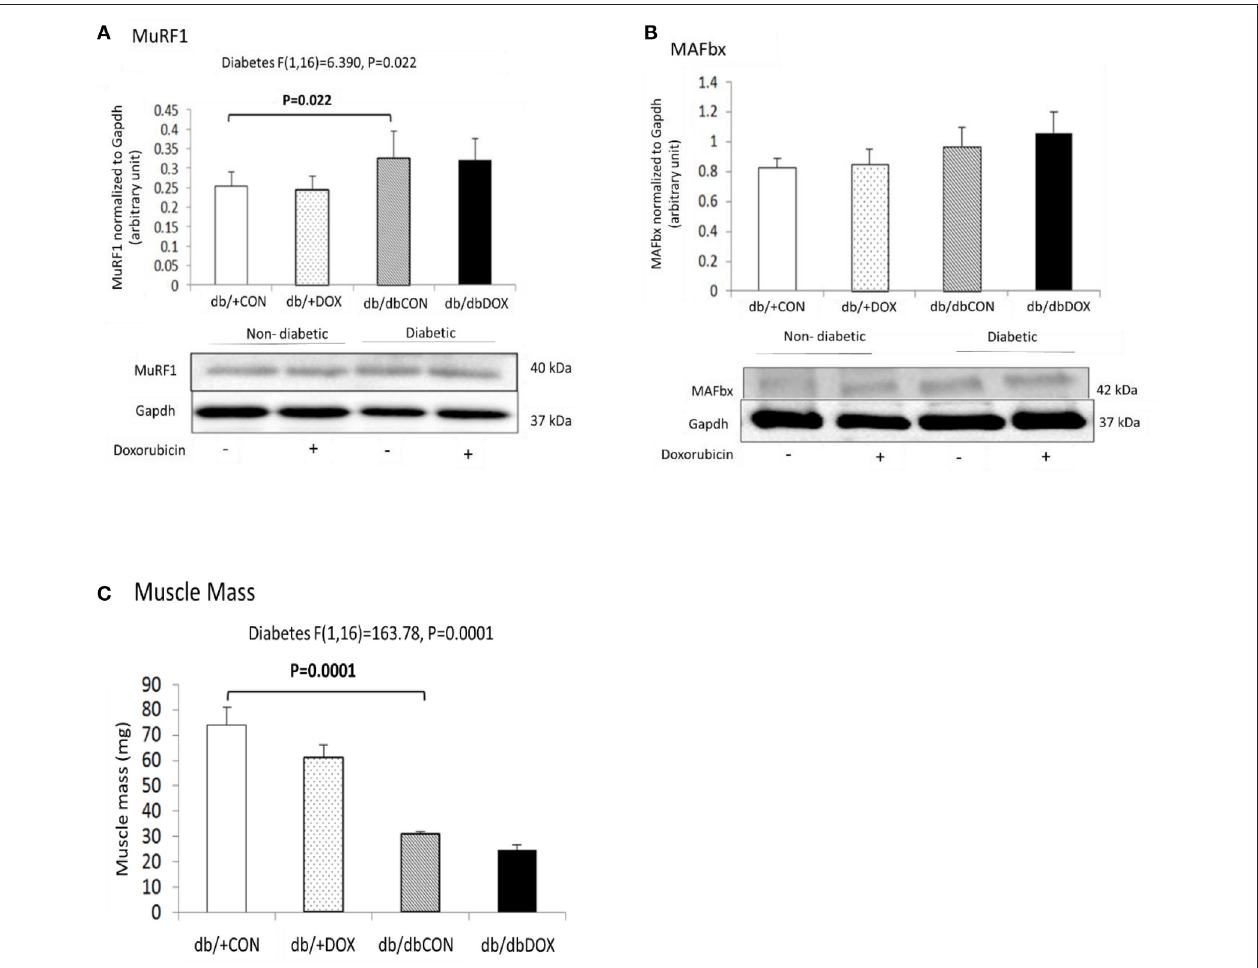
FIGURE 2 | Non-diabetic and diabetic skeletal muscle atrophy after DOX exposure examined by phosphorylation statuses of MuRF1 (A) and MAFbx (B) muscle mass (mg) (C) are shown. Data are expressed as mean ±